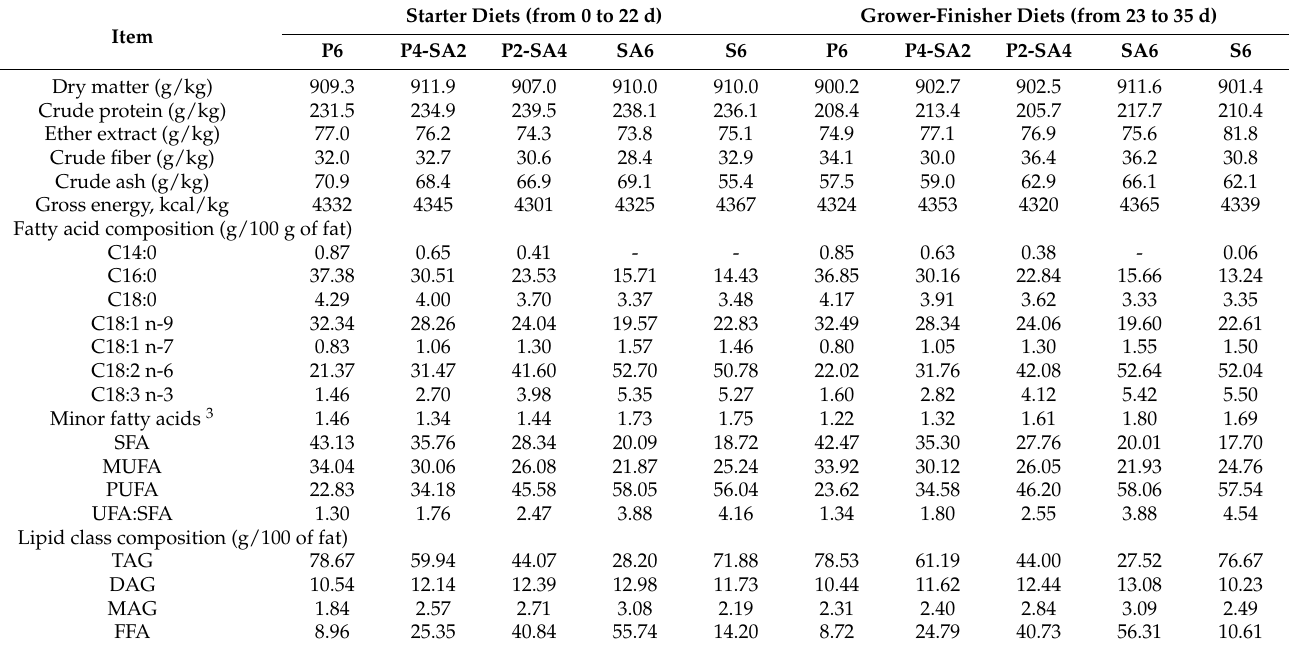
Table 3. The analyzed 1 nutritive value, fatty acid profile, and lipid class of the experimental diets 2